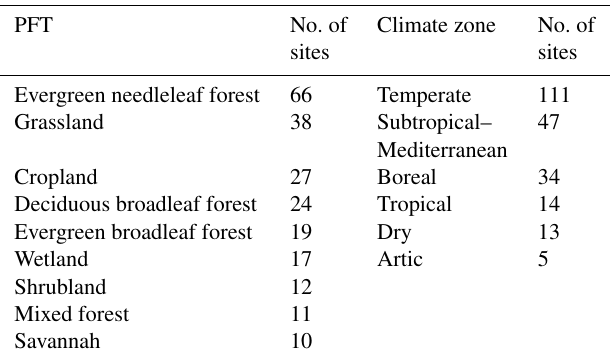
Table 1. Distribution of flux tower sites across plant functional types (PFTs) and climate zones. PFT No. of Climate zone No. of sites sites Evergreen needleleaf forest 66 Temperate 111 Grassland 38 Subtropical– 47 Mediterranean Cropland 27 Boreal 34 Deciduous broadleaf forest 24 Tropical 14 Evergreen broadleaf forest 19 Dry 13 Wetland 17 Artic 5 Shrubland 12 Mixed forest 11 Savannah